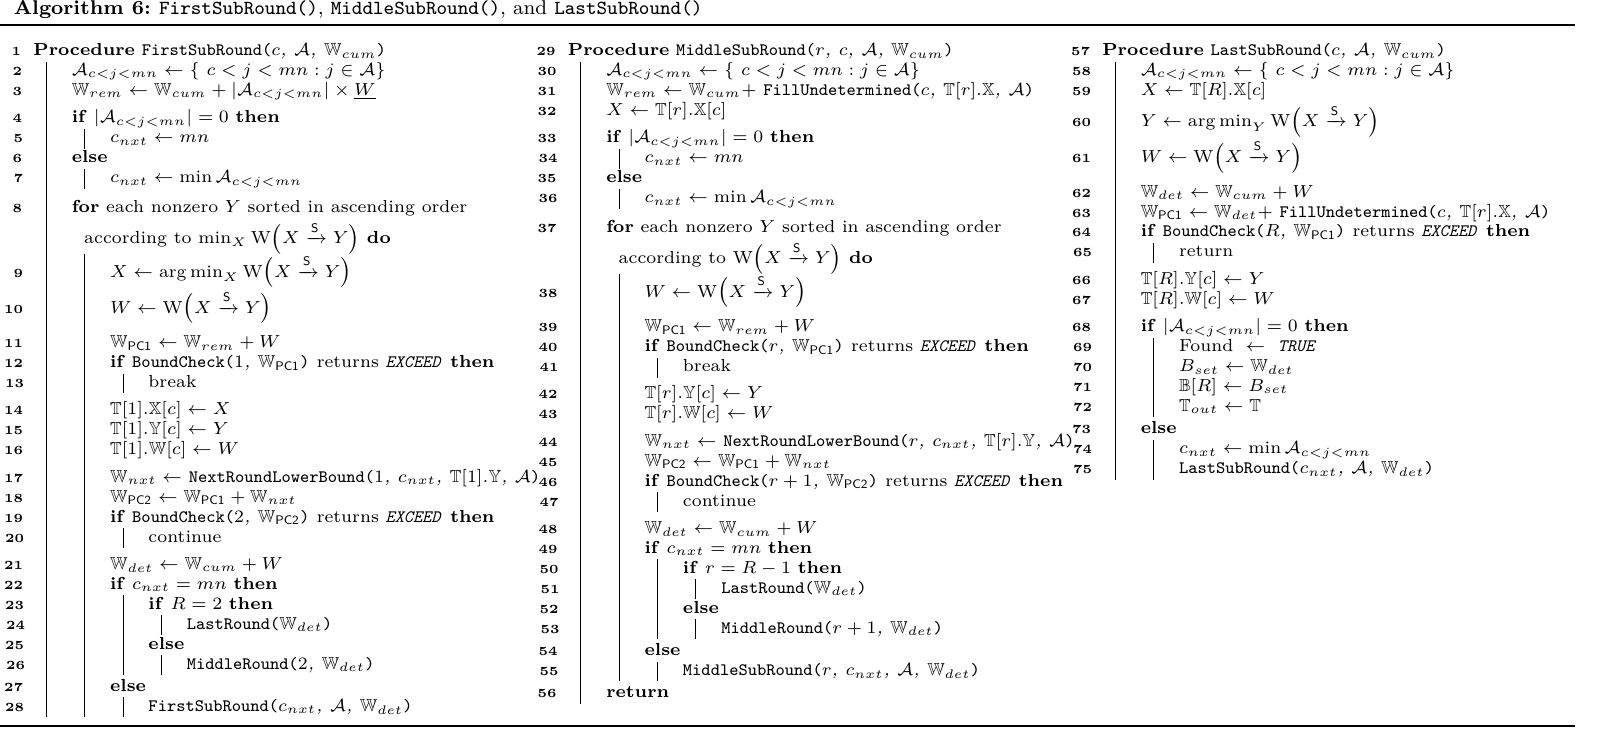
Algorithm 6: FirstSubRound() , MiddleSubRound() , and